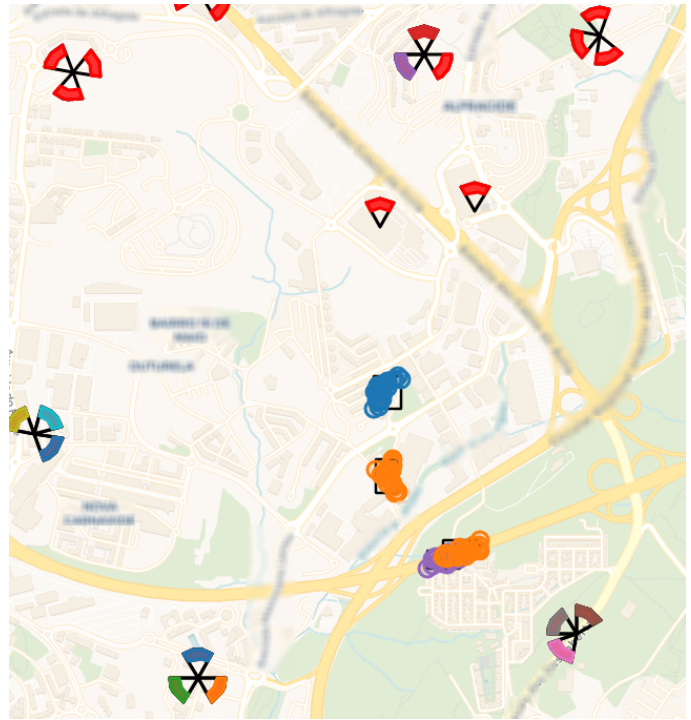
Figure 17. Result of the coverage holes algorithm for the selected cells.